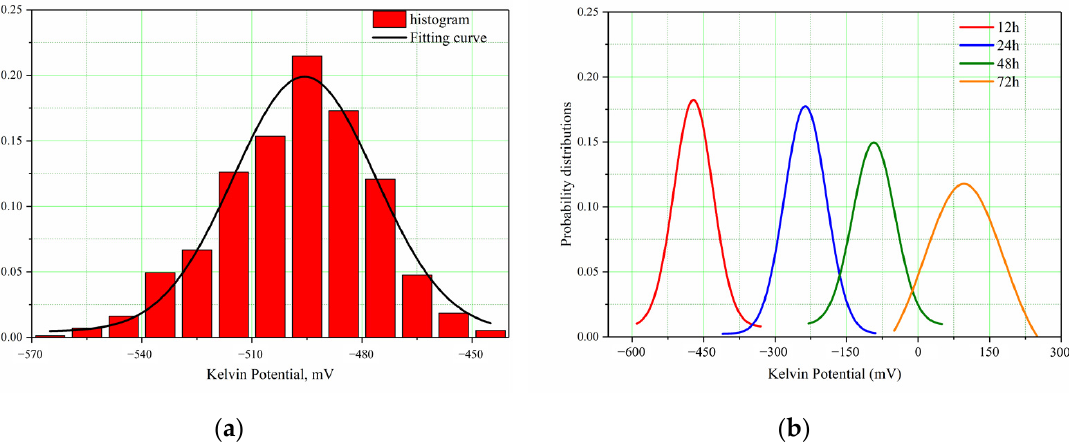
Figure 12. SKP Potential Distribution of Super 13Cr in Formate Solution. ( a ) The Histogram and Fitting Curve of Initial Potential Distribution. ( b ) The Fitting Curves of Potential Distribution of Different Time Periods. The Gaussian fitting results of the x c value and w 2 value of Sweep Scan mode poten- tial distribution at different times and the fitting error R-square are shown in Table 3. Table 3. Surface SKP Potential Gaussian Fitting of Super 13Cr Tubing after Different Times of Soak- ing in the CO 2 -Saturated Formate Solution.